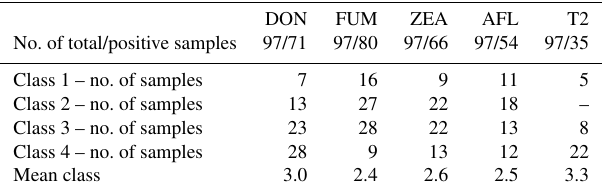
Table 3. Occurrence of mycotoxins in feedstuffs and their assignment into classes characterizing mycotoxin load of herds. DON FUM ZEA AFL T2 No. of total/positive